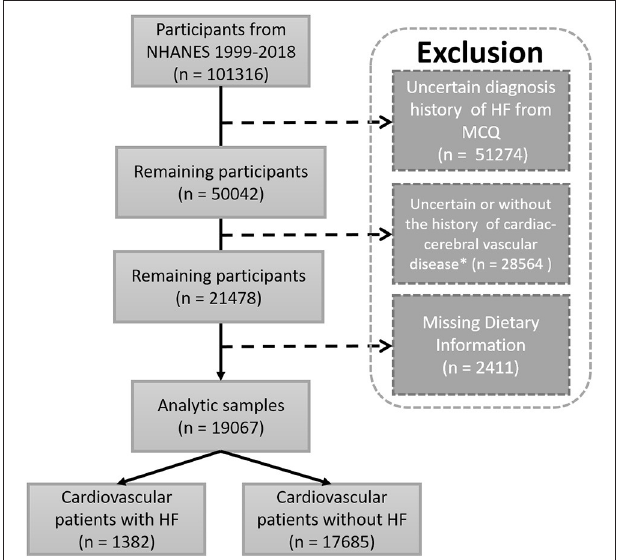
FIGURE 1 | Flow chart of study participants. Sample selection and exclusion criteria for the comparison of HF and non-HF participants, as well as the association between DII and HF. MCQ, the questionnaire of Medical Conditions; NHANES, National Survey of the National Center for Health Statistics; *Including one of the following diagnostic history: hypertension, diabetes, prediabetes, coronary artery disease, heart attack, stroke, angina.